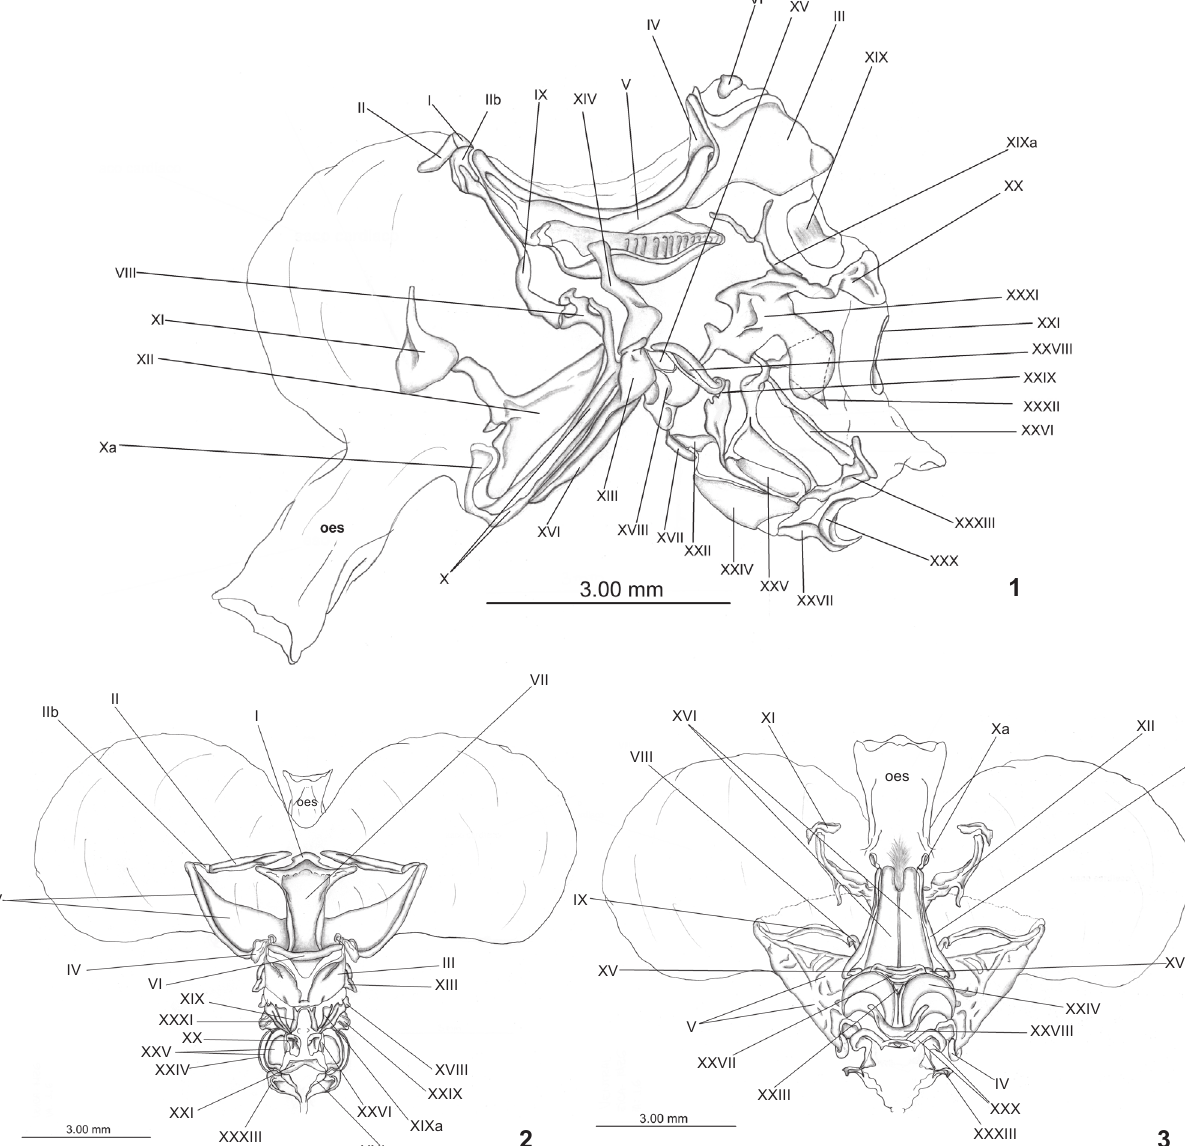
Figures 1-3. Fredius reflexifrons , cardiac and pyloric chambers of the foregut: (1) lateral view; (2) dorsal view; (3) ventral view. Mesocardiac ossicle (I), pterocardiac ossicle (II), postpterocardiac ossicle (IIb), pyloric ossicle (III), exopyloric ossicle (IV), zygocardiac ossicle (V), propyloric ossicle (VI), urocardiac ossicle (VII), pectineal ossicle (VIII), prepectineal ossicle (IX), postpectineal ossicle (X), ‘Quill’ of the postpectineal ossicle (Xa), anterior lateral cardiac plate (XI), posterior lateral cardiac plate (XII), inferior lateral cardiac ossicle (XIII), subdentate ossicle (XIV), lateral cardio-pyloric ossicle (XV), ossicle of the cardio-pyloric valve (XVI), anterior ossicle of the cardio-pyloric valve (XVI), posterior ossicle of the cardio-pyloric valve (XVII), lateral ossicle of the cardio-pyloric valve (XVIII), anterior mesopyloric ossicle (XIX), lateral mesopyloric ossicle (XIXa), posterior mesopyloric ossicle (XX), uropyloric ossicle (XXI), preampullary ossicle (XXII), anterior inferior pyloric ossicle (XXIII), inferior ampullary ossicle (XXIV), ampullary roof ossicle, lower portion ossicle (XXV), ampullary roof ossicle, upper portion ossicle (XXVI), posterior inferior pyloric ossicle (XXVII), anterior supra-ampullary ossicle (XXVIII), middle supra-ampullary ossicle (XXIX), posterior supra-ampullary ossicle (XXX), anterior pleuropyloric ossicle (XXXI), middle pleuropyloric ossicle (XXXII), posterior pleuropyloric ossicle